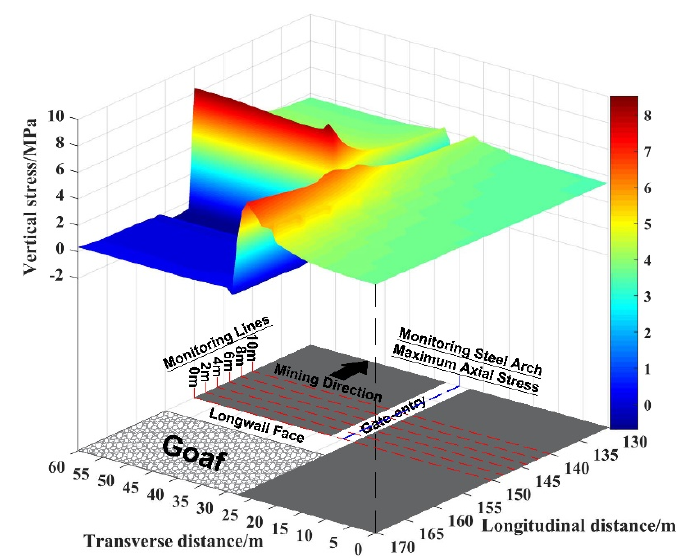
Figure 14. Three-dimensional (3D) schematic of the vertical stress above the mining panel at 100 m of depth.